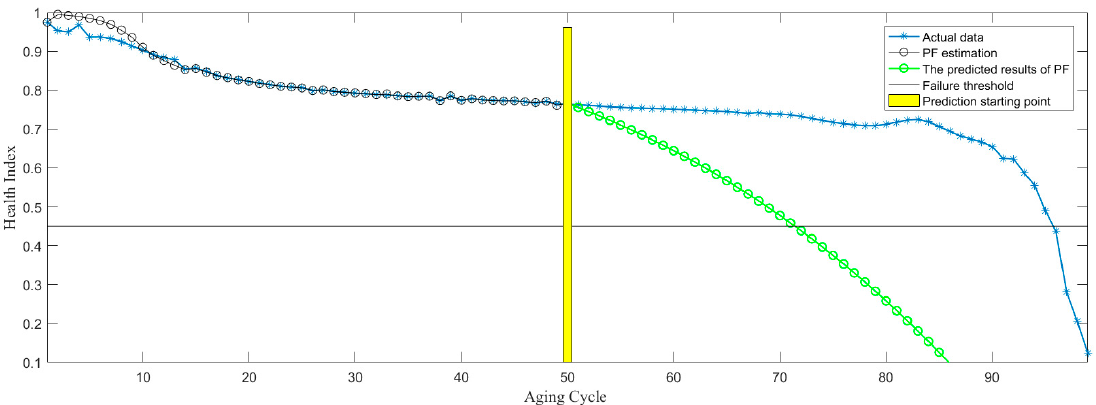
Figure 13. RUL (remaining useful life) prediction based on starting point 50 cycle.